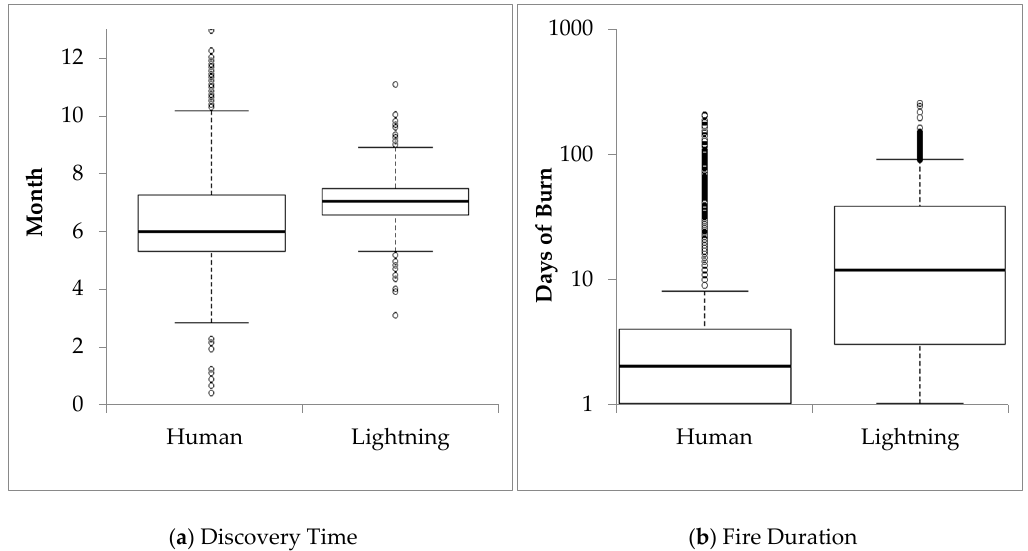
Figure 5. General differences between lightning- and human-caused fire ignitions in interior Alaska as determined by Kruskal–Wallis tests for ( a ) discovery time and ( b ) fire duration.